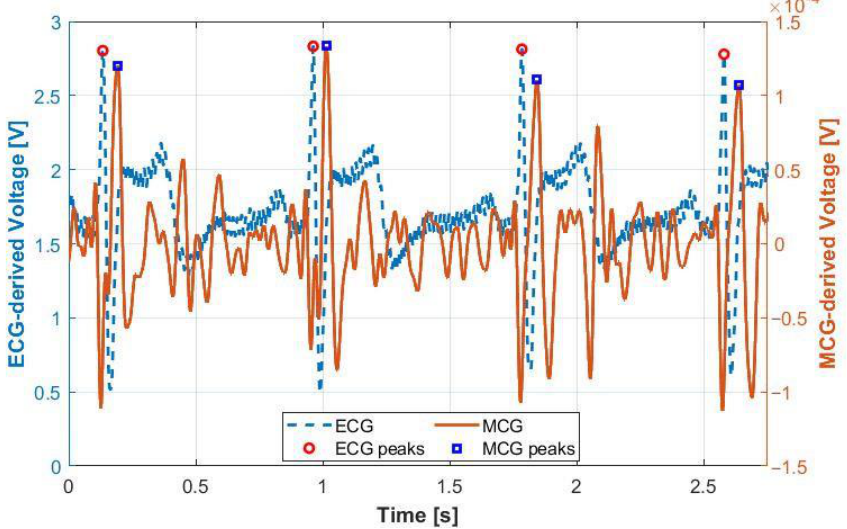
Figure 2. Comparison of MCG and ECG signals recorded on a human participant for the same time duration. Table 2. MCG- and ECG-derived HRV parameters for a human participant across 7 trials.